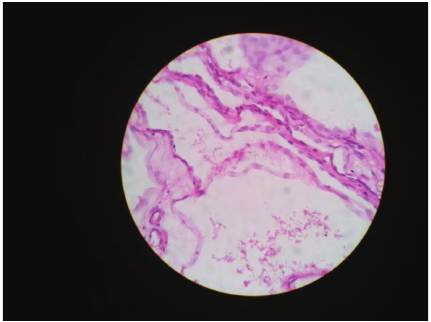
Figure 4: Microscopy shows cuboidal epithelium lined tumor filled with eosinophilic proteinaceous material. Intervening septae showed fibrosis and dense lymphoplasmacytic infiltrate admixed with eosinophils and neutrophils. Microscopic picture of